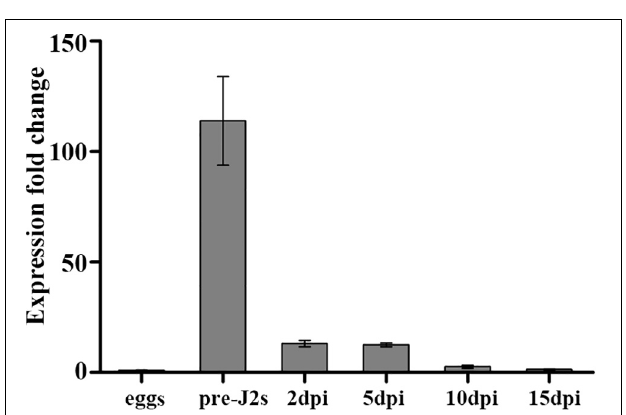
of Mg-PEL1: Strep. As a control, no bands were observed in the EV sample ( Figure 5A ), showing the correct expression of recombinant protein Mg-PEL1: Strep. For enzymatic activity analysis, culture supernatants of Mg-PEL1: Strep protein and